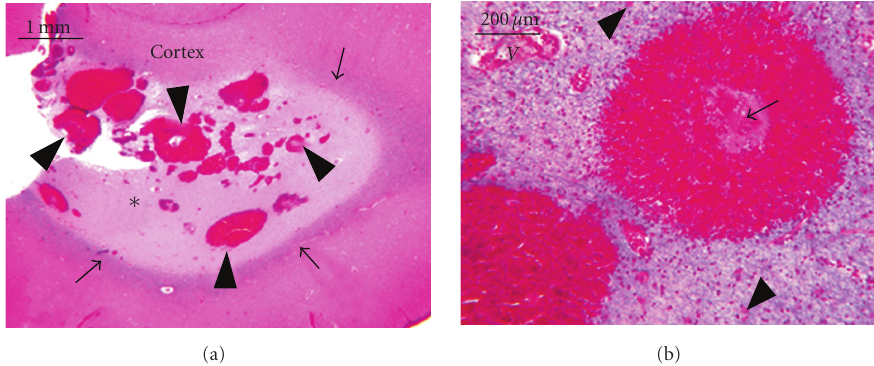
Figure 1: White matter hemorrhages associated with DKA. (a) This low-power view of a gyrus (stained with hematoxylin, eosin, and Luxol fast blue) illustrates multiple small and microscopic hemorrhages (arrowheads) associated with “confluent” pallor (asterisks) of the myelin, a thin layer of preserved subcortical myelin (arrows), and normal cortex. (b) A vessel, labeled V , is identified for reference. Stained with Luxol fast blue, hematoxylin, and eosin (which stains myelin blue). Central hemorrhage was formed by perivascular necrosis (arrow), a concentric ring of red blood cells, and di ff usely rarefied white matter that is speckled with eosinophilic astrocytes (arrowheads). Figure 1 reproduced with permission from Pediatrics , volume 126, page 1543, copyright 2007 by the